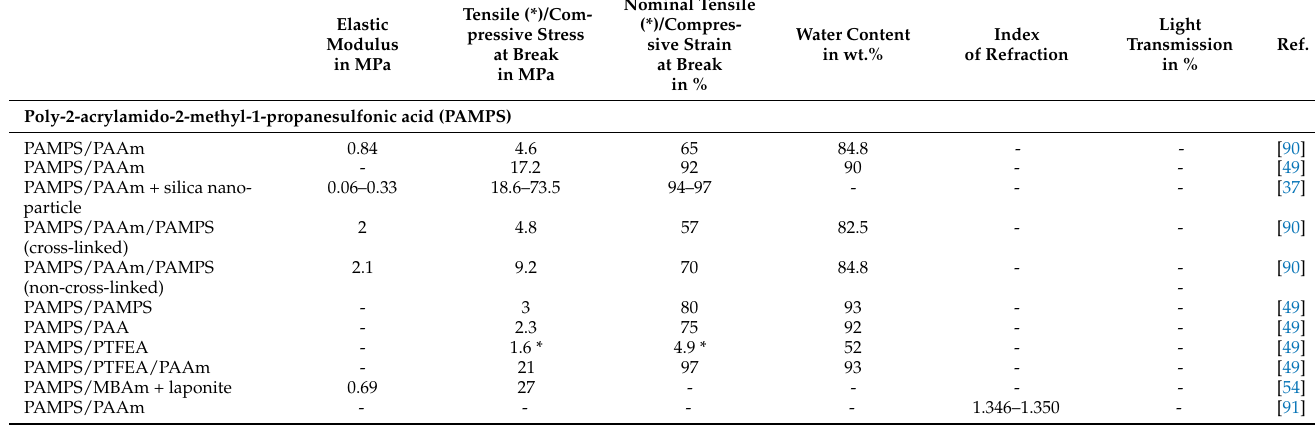
Table 3. Mechanical and optical values for the seven hydrogel